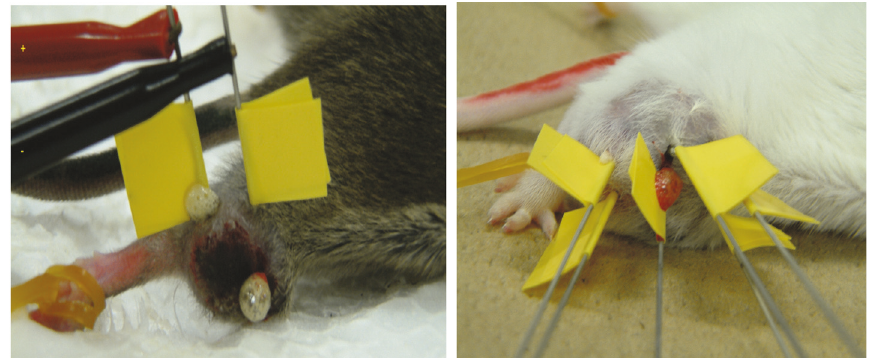
Figure 2: Case of electrochemical therapy in the right upper thigh mass. There is 1cm distance between the